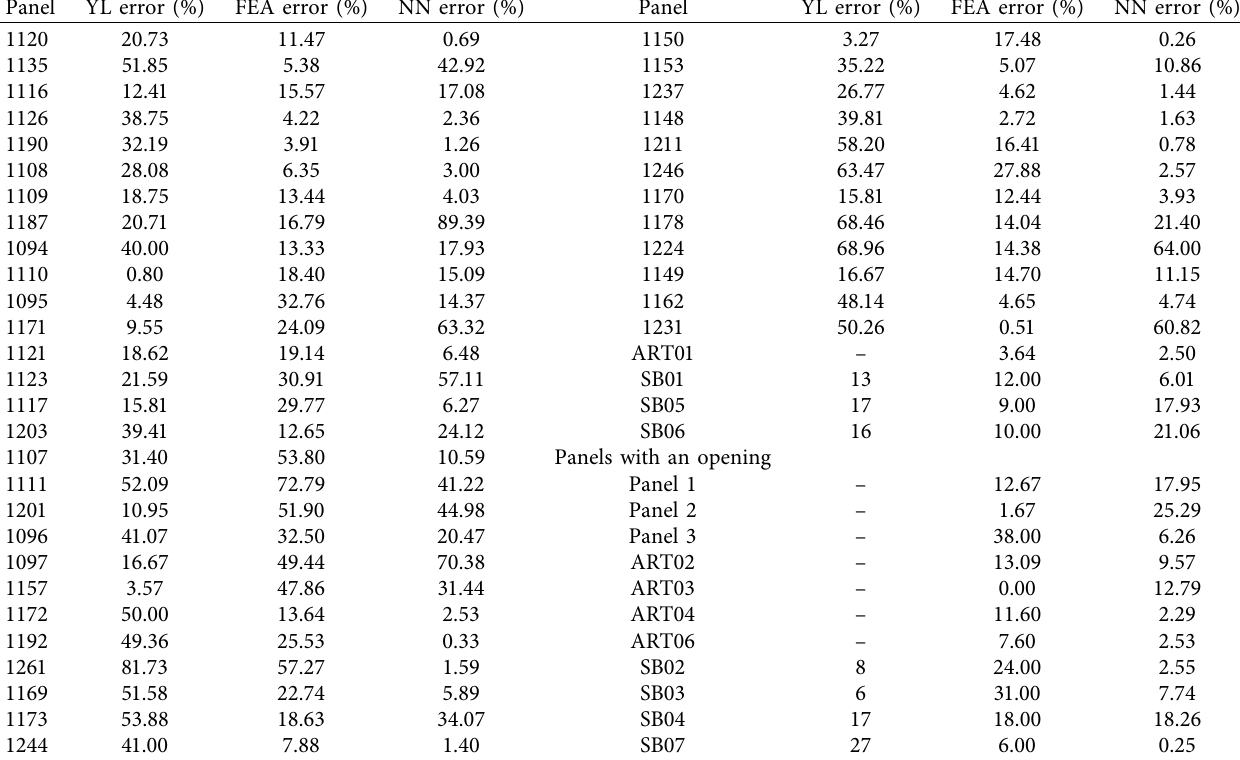
Table 5: Comparison between NN, FEA, and YL accuracy of prediction.